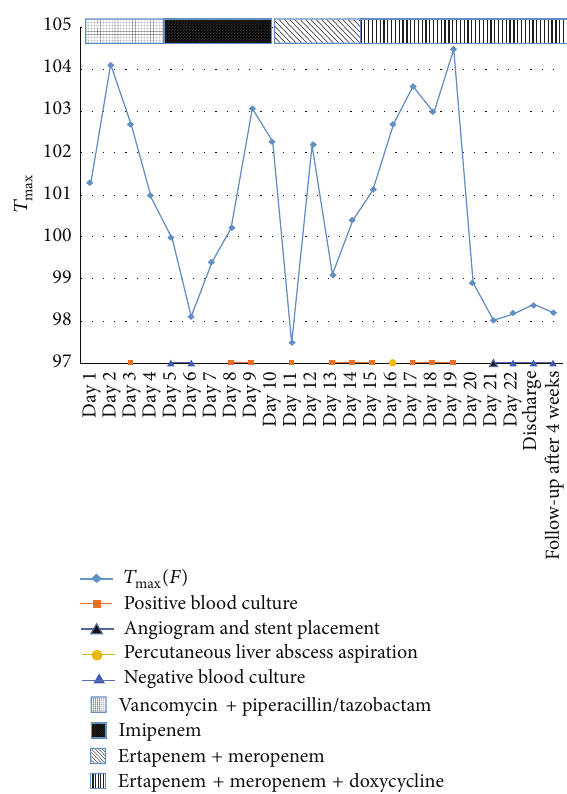
Figure 2: Timeline graph to depict various clinical parameters during the admission and after discharge from hospital.